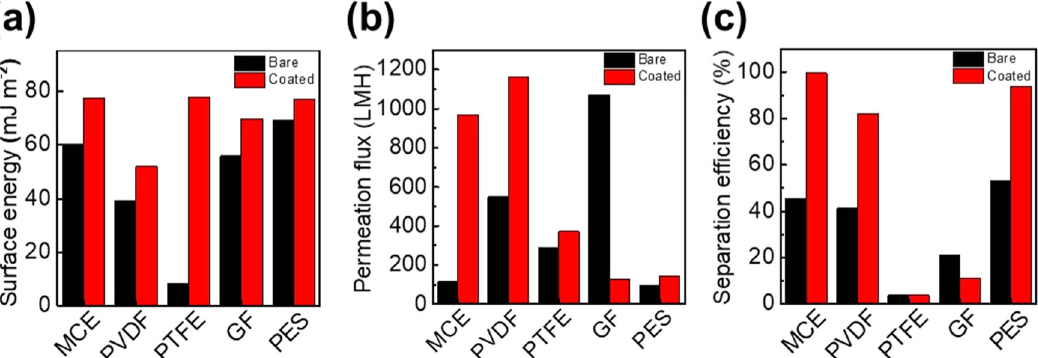
Fig. 3 Selected properties of bare and coated membranes. a Surface free energy; b permeation fl ux; c separation ef fi ciency of fi ve membranes in bare and coated